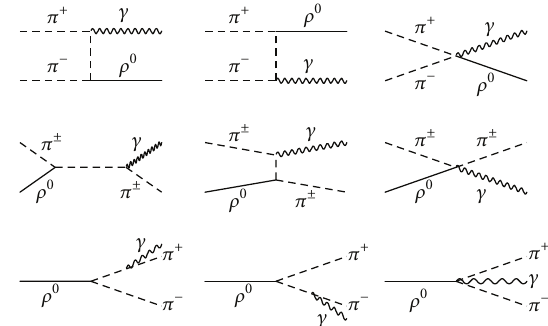
Figure 5: Photon-producing reactions and decays in hadronic